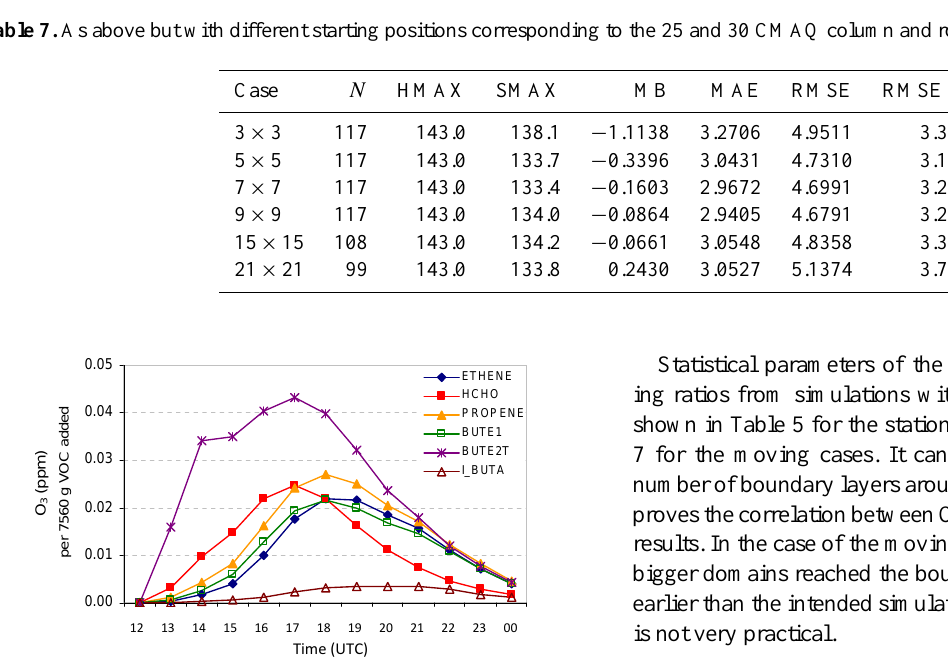
Figure 7. Changes in ozone mixing ratios due to emission spikes of different individual VOCs simulated with STOPS along the trajec- tory on 25 August. The values are integrated over the grid cells in the surface layer of the STOPS